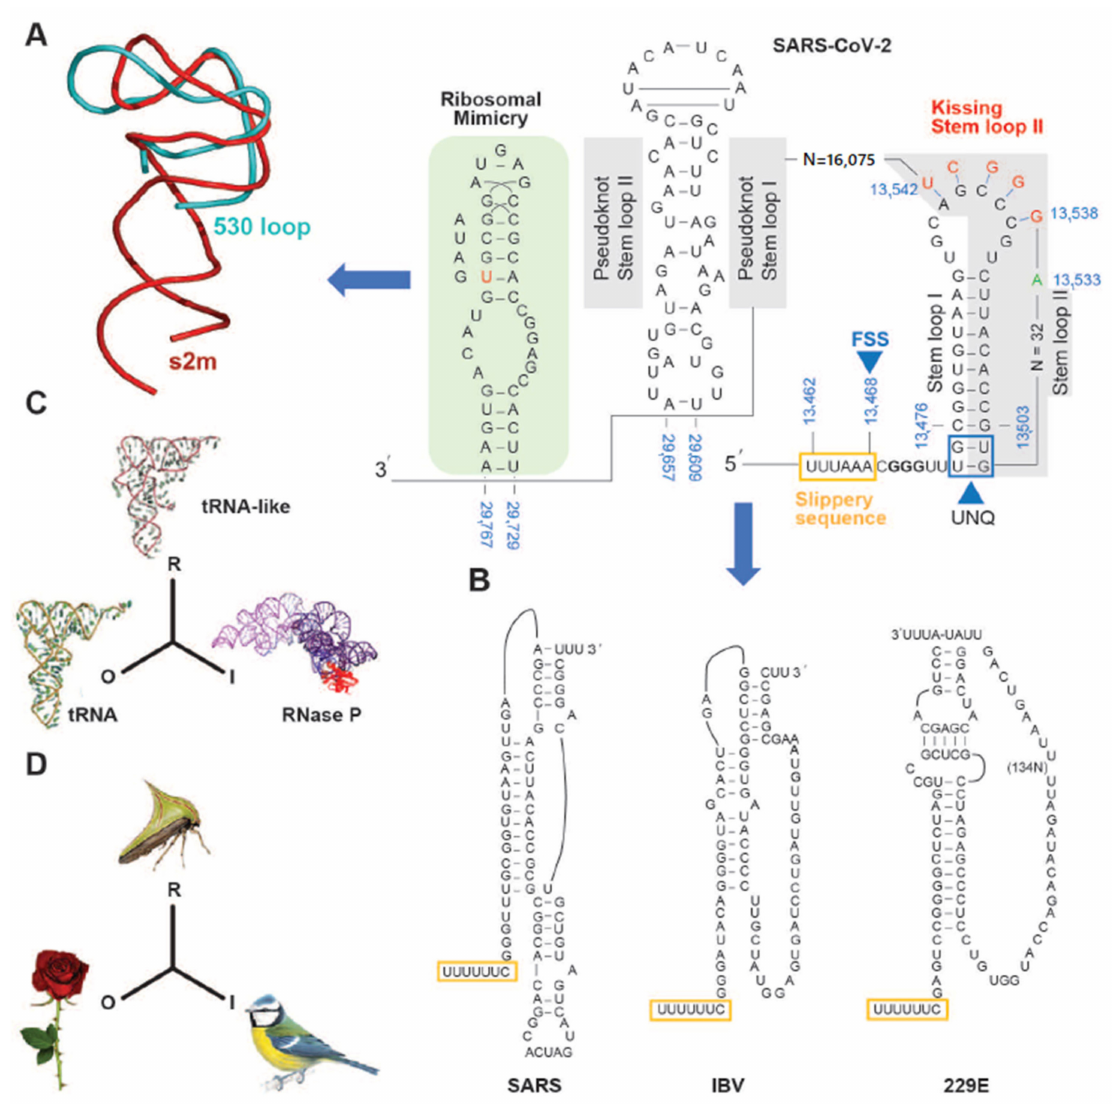
Figure 2. Sequences within the SARS-CoV-2 genome are involved in ribosomal frameshifting and RNA stem-loop structural formation. ( A ) The predicted standard coronavirus heptanucleotide shift site U_UUA_AAC is present and shown with the slippery sequence (brown box) and frame shift site (FSS) followed by a guanine conservation sequence (bold). An unpaired G:U nucleotide quartet (UNQ: boxed) may offer stability to the stem loop I and II. Binding between the stem loops and a downstream nucleotide region (13,538–13,542 bp) results in “kissing” stem loop II formation. A variant in SARS-CoV-2 (13533C->A) compared to SARS-CoV is indicated. Potential pseudoknot stem loops occur between 29,609–29,657 bp (grey box). Conservation element s2m (stem-loop II motif, pale green box) is shown that may partake in 16S ribosomal RNA macromolecular mimicry. Ribbon diagram (left of arrow) showing the similarity in the backbone folds between the s2m structure (red) and the 530 loop of the 16S rRNA (blue). ( B ) Sequence and base-pairing of three different coronavirus stimulatory elements; SARS three-stemmed pseudoknot [24,25], the avian infectious bronchitis virus (IBV) two-stemmed pseudoknot [26], and the kissing loops of the human coronavirus 229E stimulatory element [17]. The heptameric slippery sites are shown (yellow rectangles). ( C , D ) Models of mimetic relationships corresponding to the representamen: R, the model to the object: O and the operator to the interpretant: I [27]. A molecular example ( C ): the tRNAPhe is considered to be the object, the untranslated end of the plant virus TYMV genome is the representamen, while the interpretant is the tRNA precursor processing enzyme RNase P Modified from [23]. In ( D ), the plant’s thorn is the object, the thorn bug is the representamen and the predatory bird that the prey eludes is the interpretant. Modified from